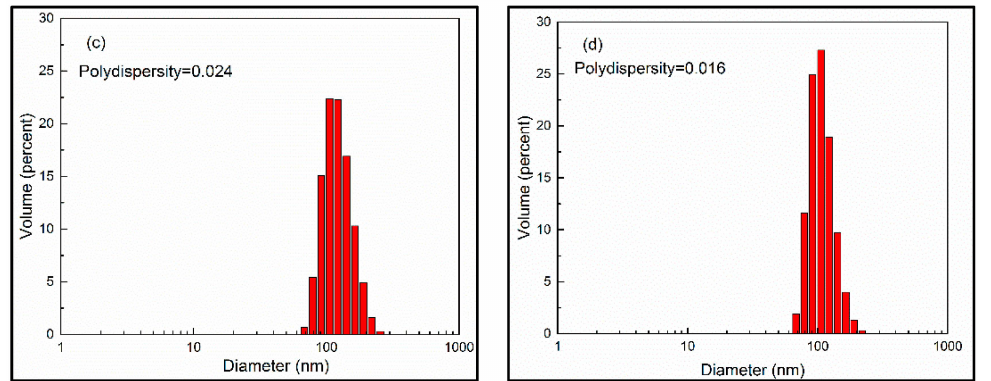
Figure 3. Particle size distribution of final latex particles prepared by emulsion polymerization of styrene using methanol solution (20/80 w / w ) as the polymerization medium and various amount of initiator KPS: ( a ) 0.3 wt %; ( b ) 0.6 wt %; ( c ) 0.9 wt %; and ( d ) 1.2 wt %.